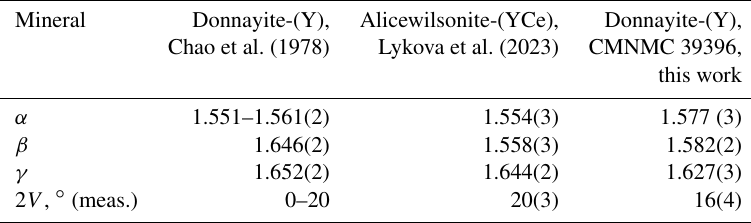
Table 3. Comparative optical properties of donnayite-(Y) (original and current study) and alicewilsonite-(YCe). Mineral Donnayite-(Y), Alicewilsonite-(YCe),